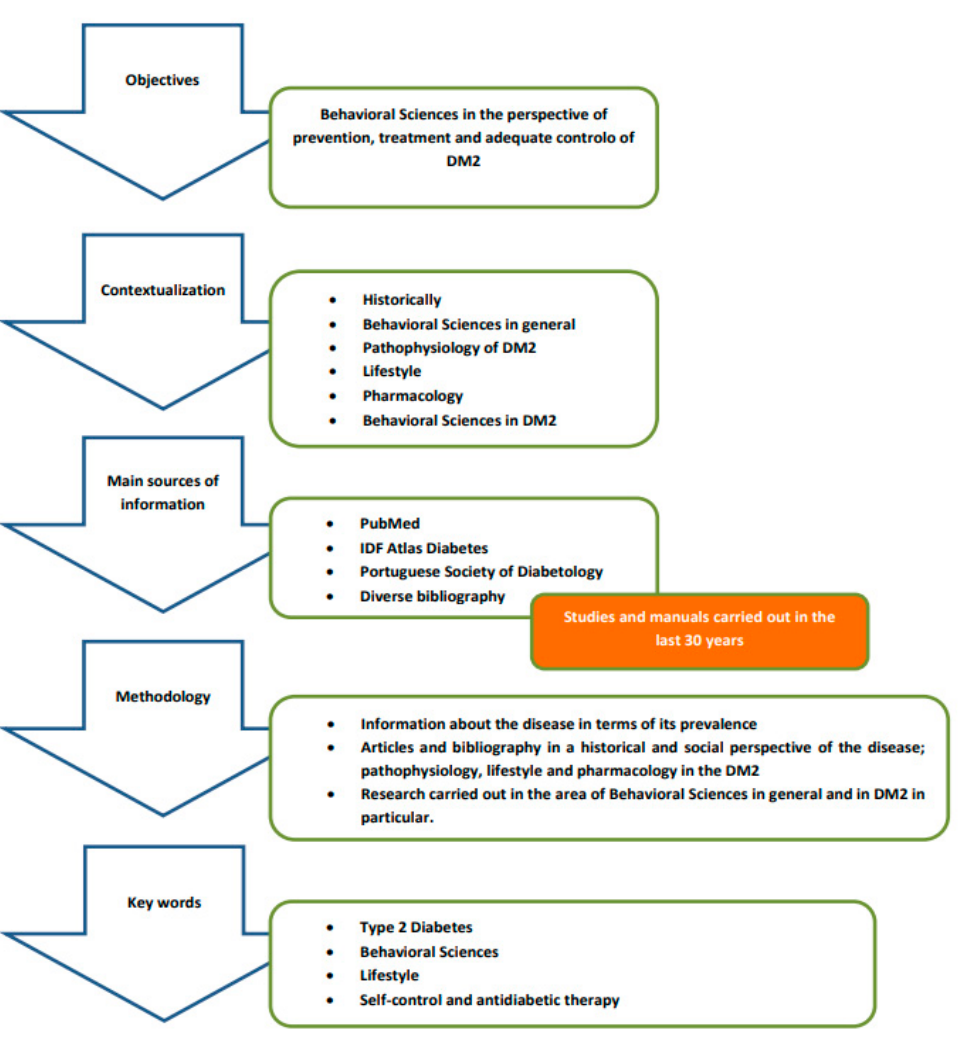
Figure 5. Research methodology and information